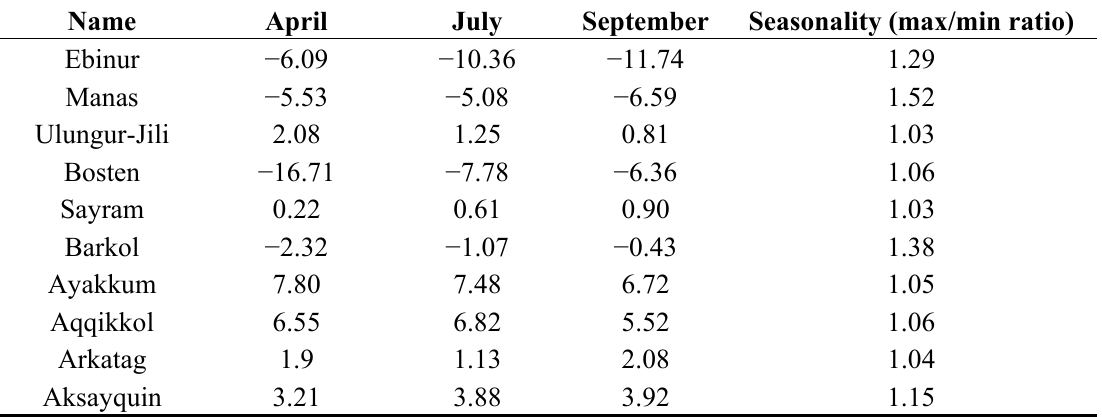
Figure 5. Inter-annual variation in the surface area of major lakes for the months of April, July, and September in XUAR from 2000 to 2014. Solid, dashed, and dotted lines represent April, July, and September, respectively. Table 3. Changing trend in the surface area of major lakes in XUAR from 2000 to